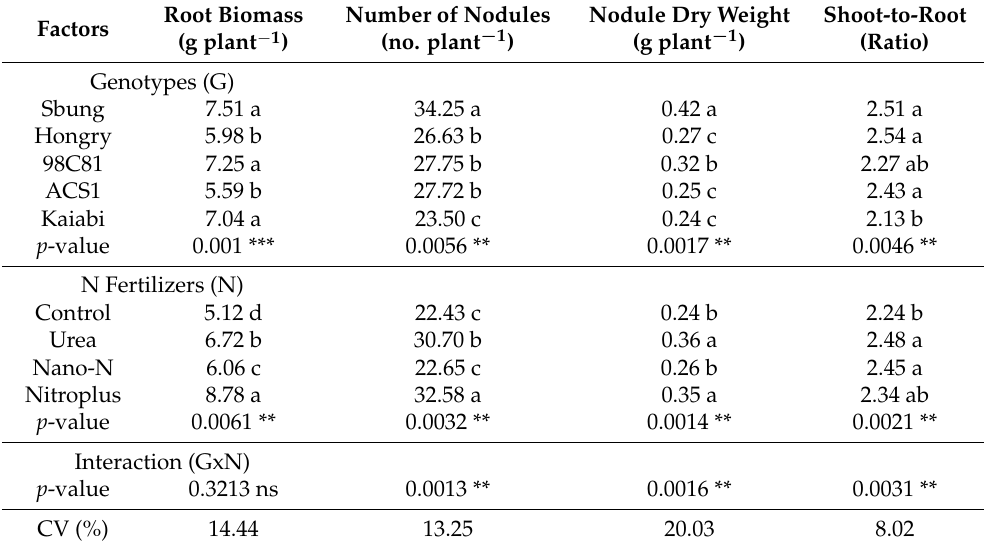
Table 3. Root biomass, number of nodules, nodule dry weight, and shoot to root ratio, as affected by genotypes and N fertilizer